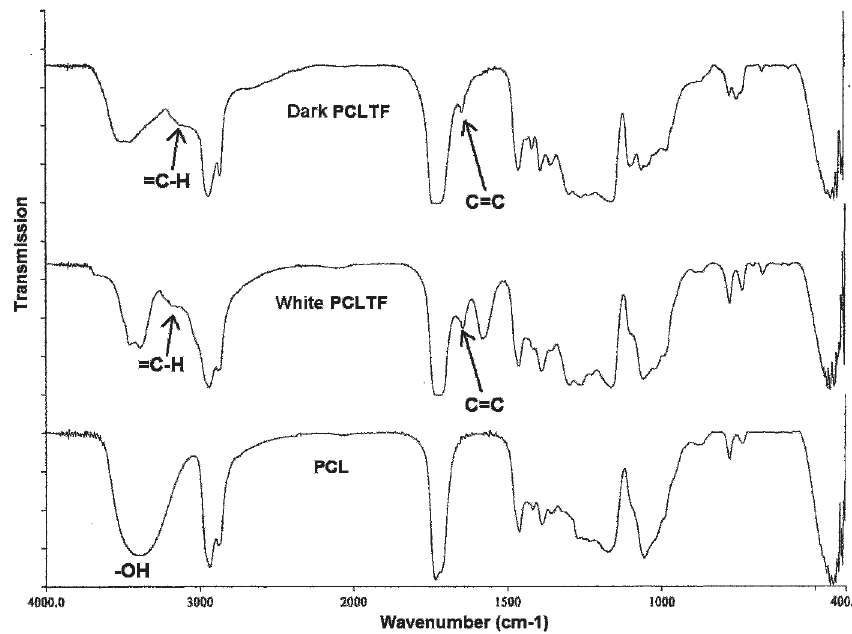
Figure 2 - FT-IR spectra of dark PCLTF, white PCLTF and